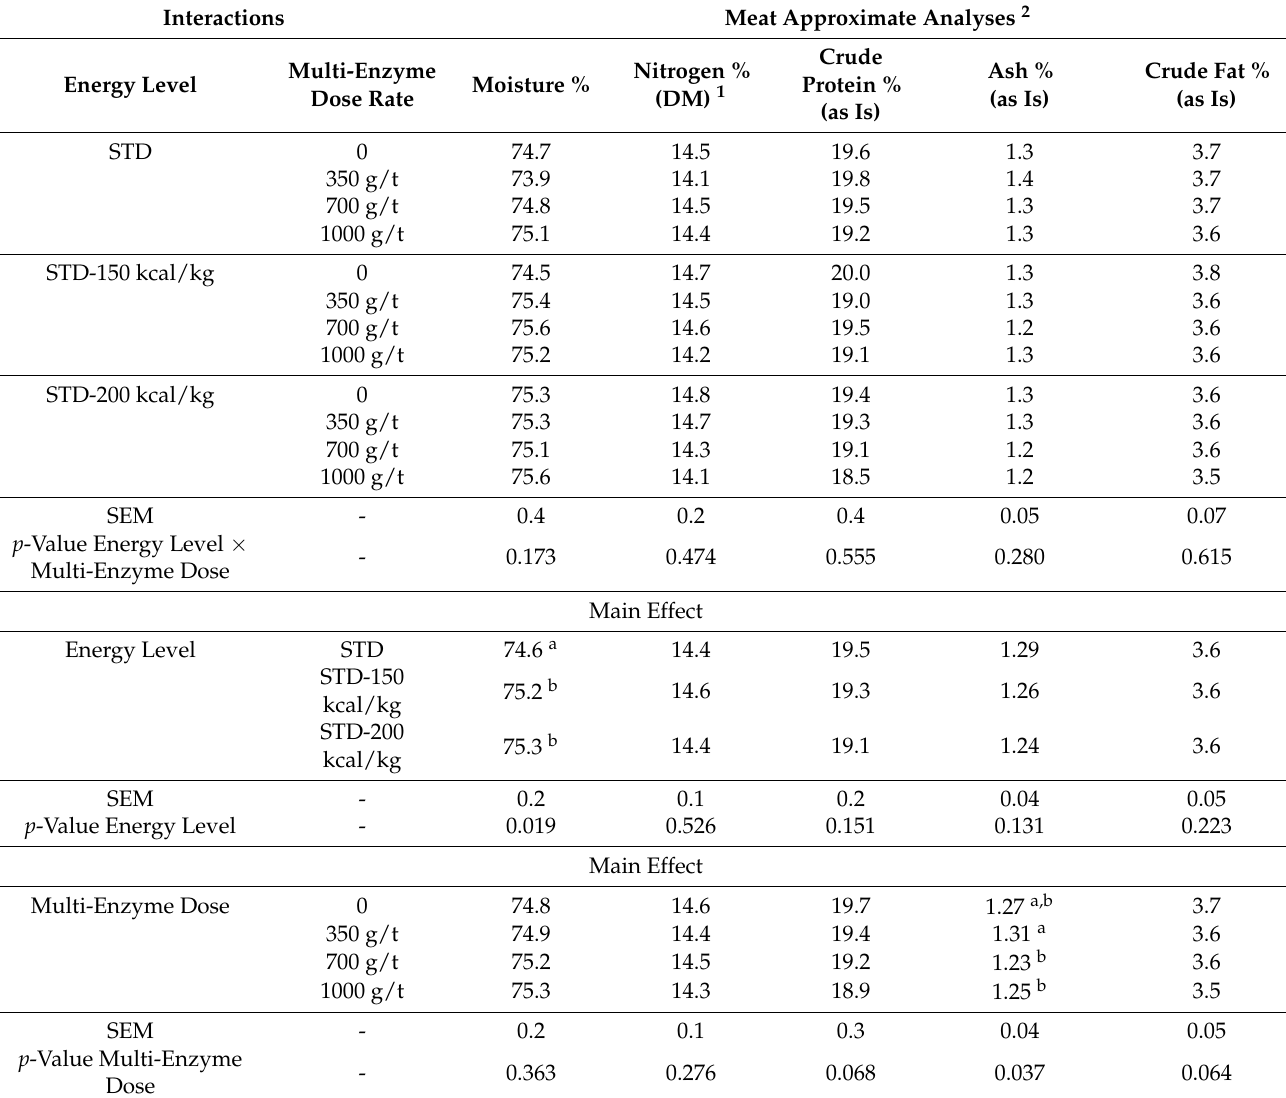
Table 6. Effects of multi-enzyme super-dosing in reduced energy diets on meat approximate analyses of broiler chicken. Interactions Meat Approximate Analyses 2